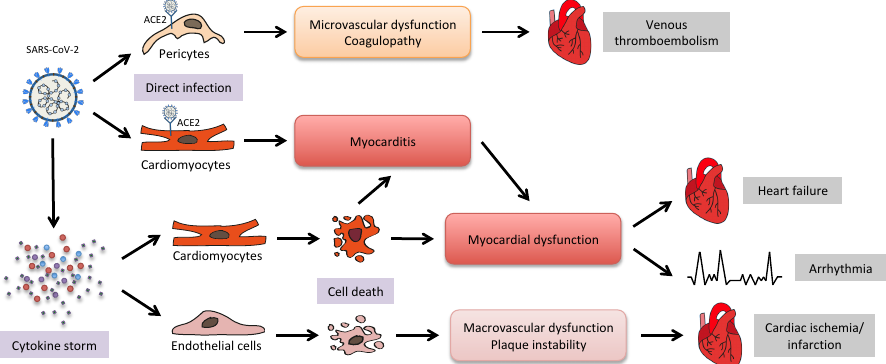
Figure 2. Potential mechanisms of cardiac injury in